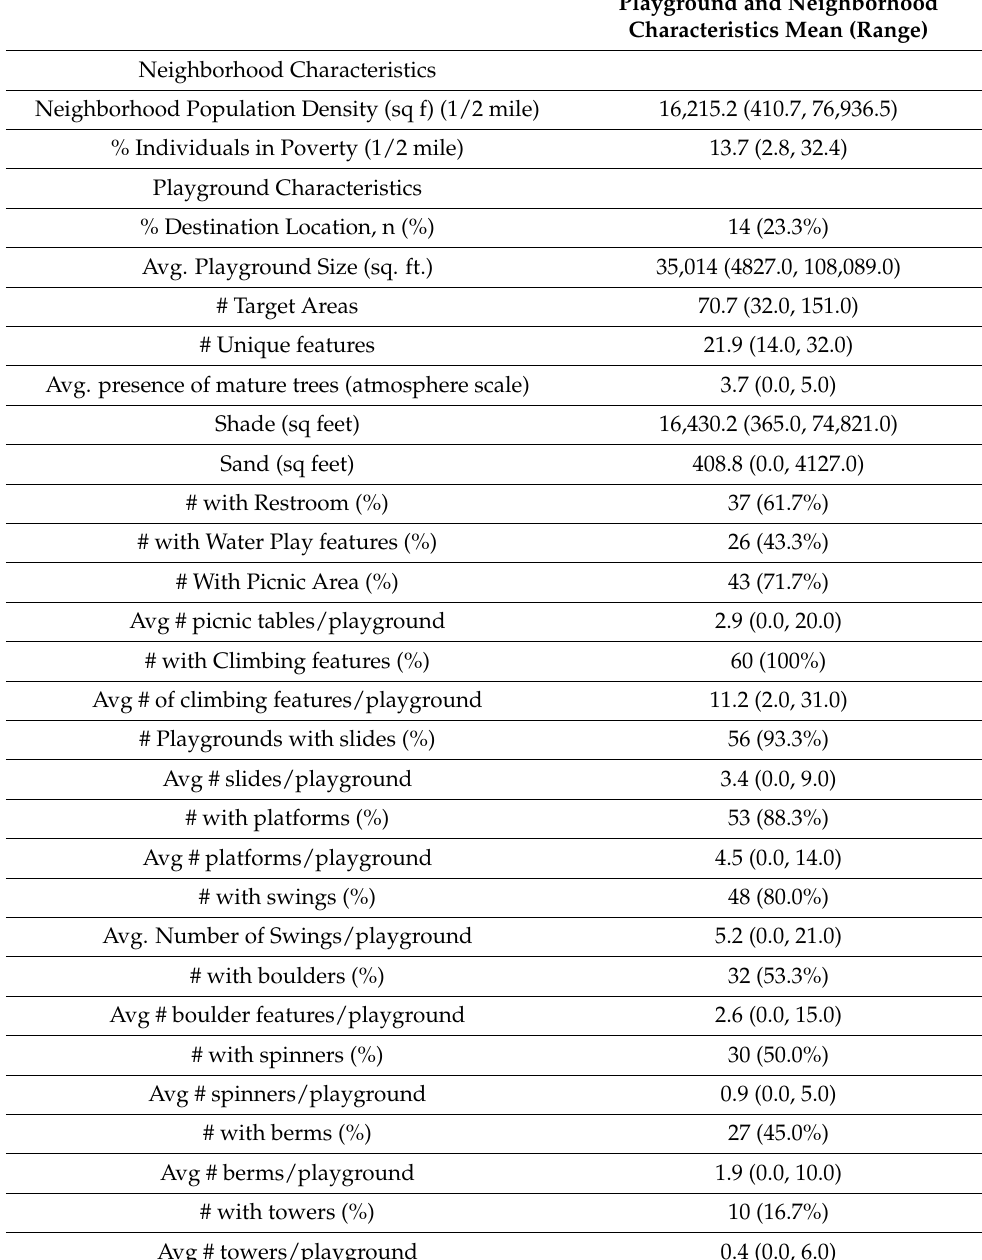
Table 1. Descriptive characteristics of